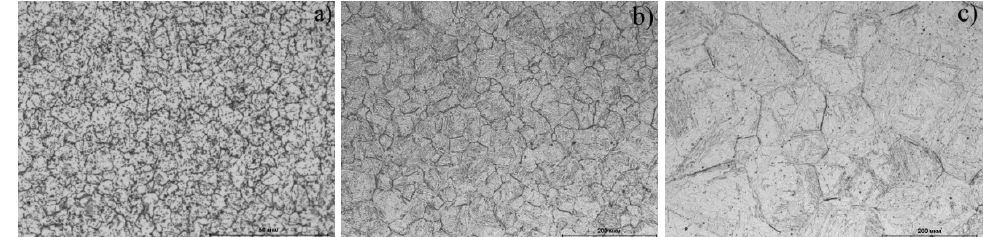
Figure 5. The microstructures of ChS-139 steel after cooling down from ( a ) 825 °C, ( b ) 1200 °C, and ( c ) 1300 °C.